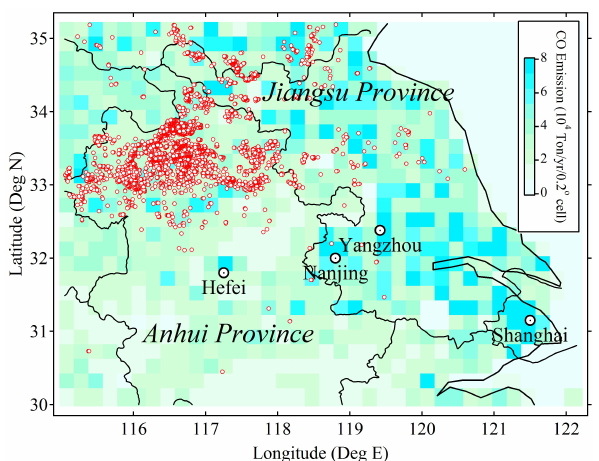
Fig. 2. A map showing emission inventory of carbon monoxide and fire events on 9 June 2012 in the study region. Note: CO emission inventory was provided by Q. Zhang at Tsinghua University (Zhang et al., 2009). The fire data are from MODIS Collection 5 Active Fire Product provided by University of Maryland (Giglio et al.,